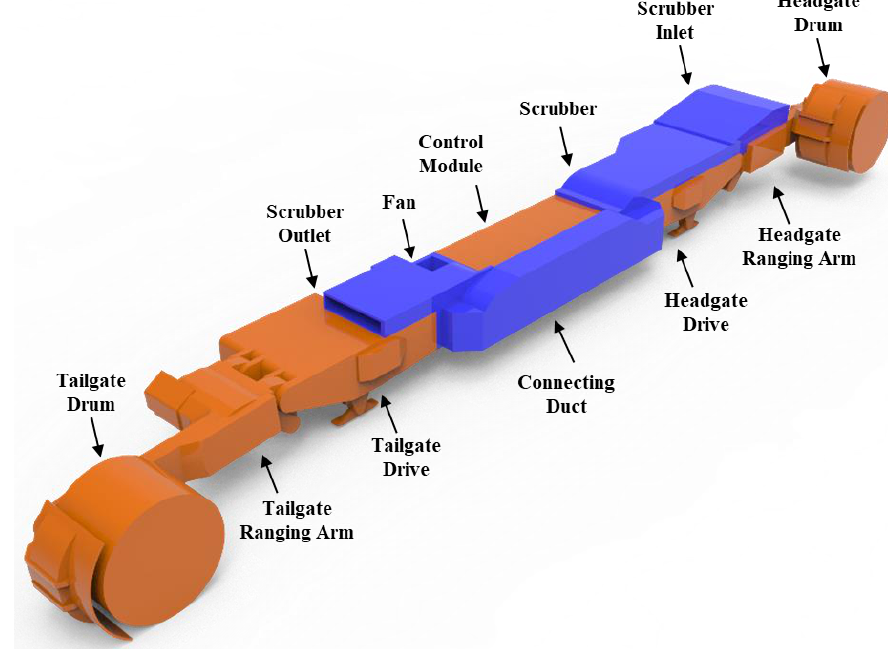
Figure 1. Design of longwall shearer with an integrated flooded-bed scrubber.